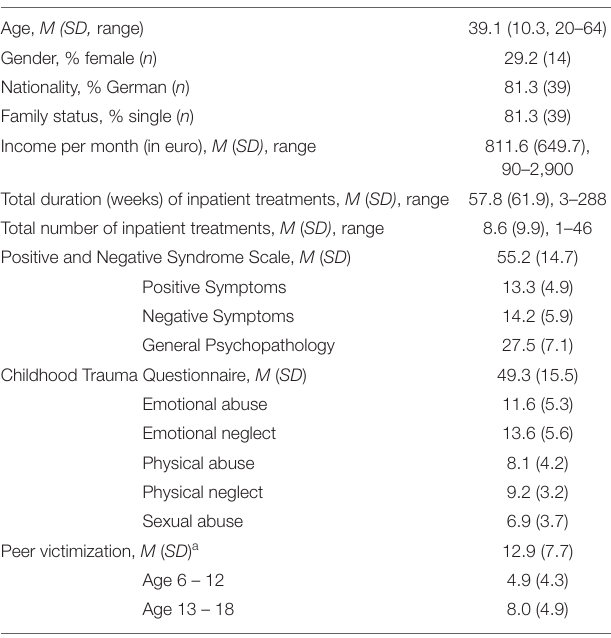
TABLE 1 | Subject characteristics and mean values on psychopathology measures ( N =